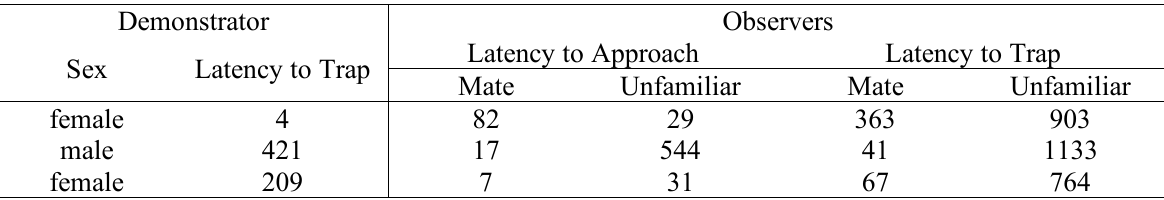
Latency (in minutes) for captive coyotes to approach and get captured in a trap in Experiment 3.